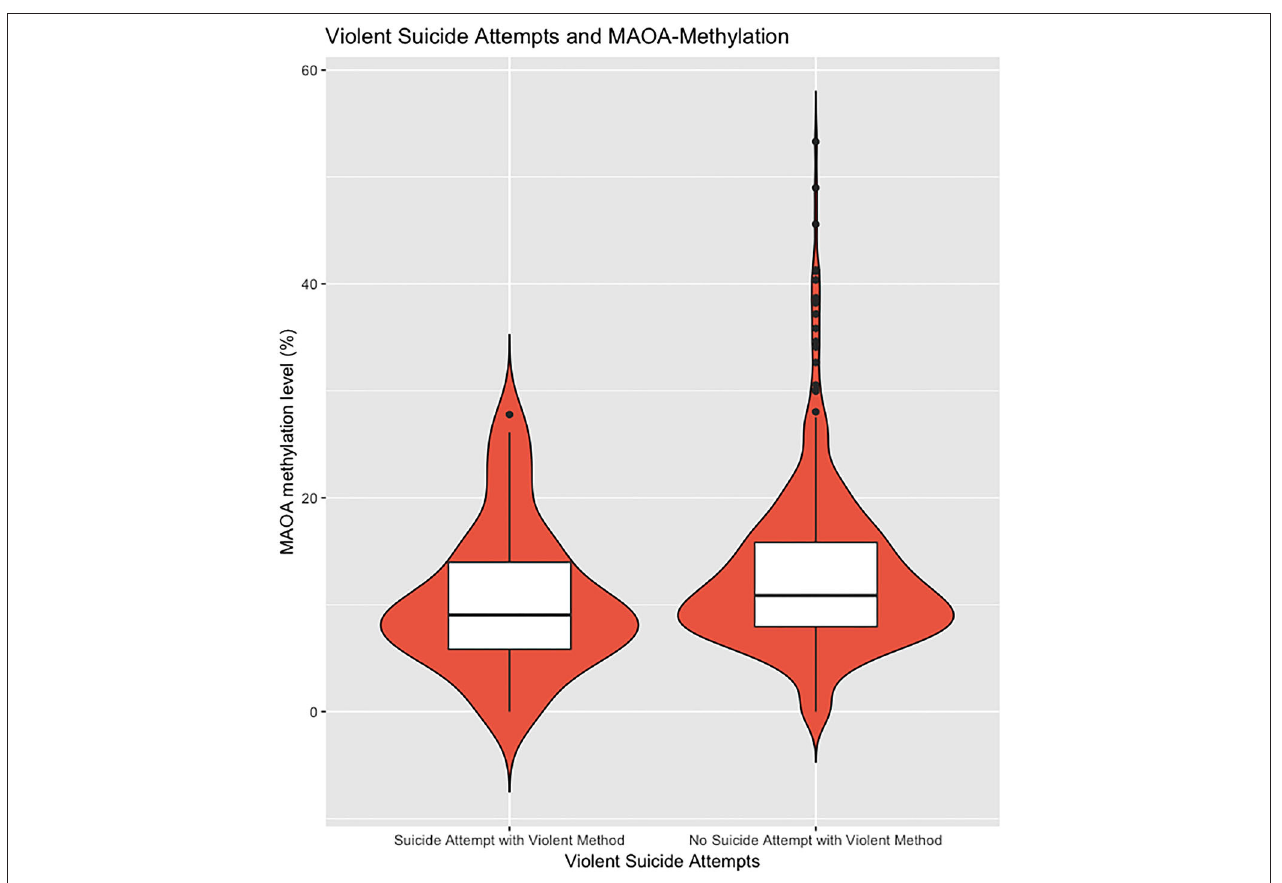
FIGURE 1 | The extent of methylated DNA at MAOA exon I promoter in peripheral blood of female affective disorder patients with a history of violent suicide attempt(s) (10.31 ± 6.61%; n = 51) compared to female patients without any history (13.12 ± 11.93%; n = 476; p = 0.01; t-test). Violin plot with median and interquartile